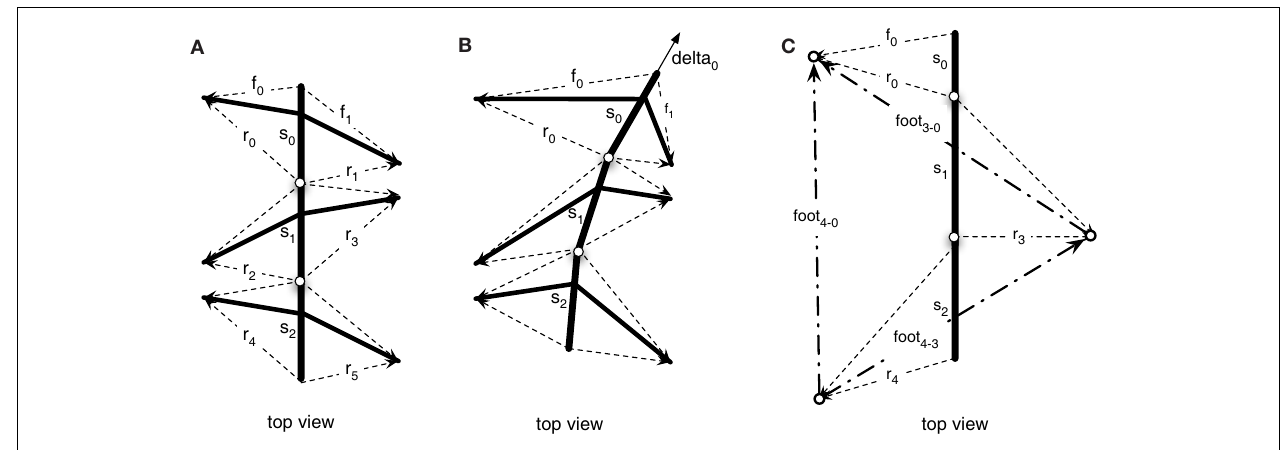
at the front (delta vector) and the foot points are kept in place. (C) Shows an example configuration during walking, with only three legs on the ground (front left, middle right, hind left).